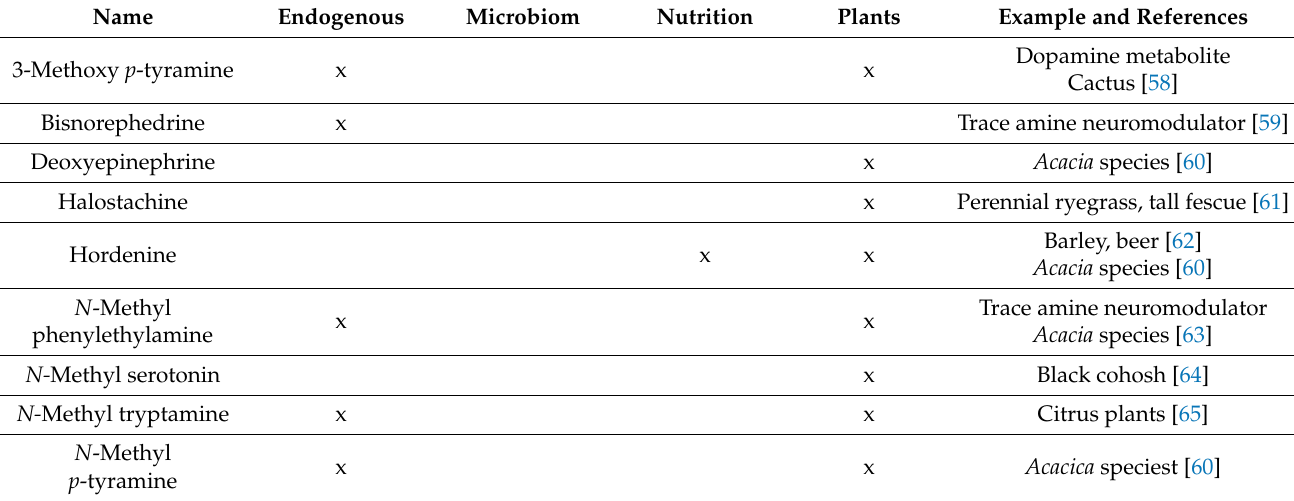
Table 2. Typical origin of trace amine-like compounds investigated in this